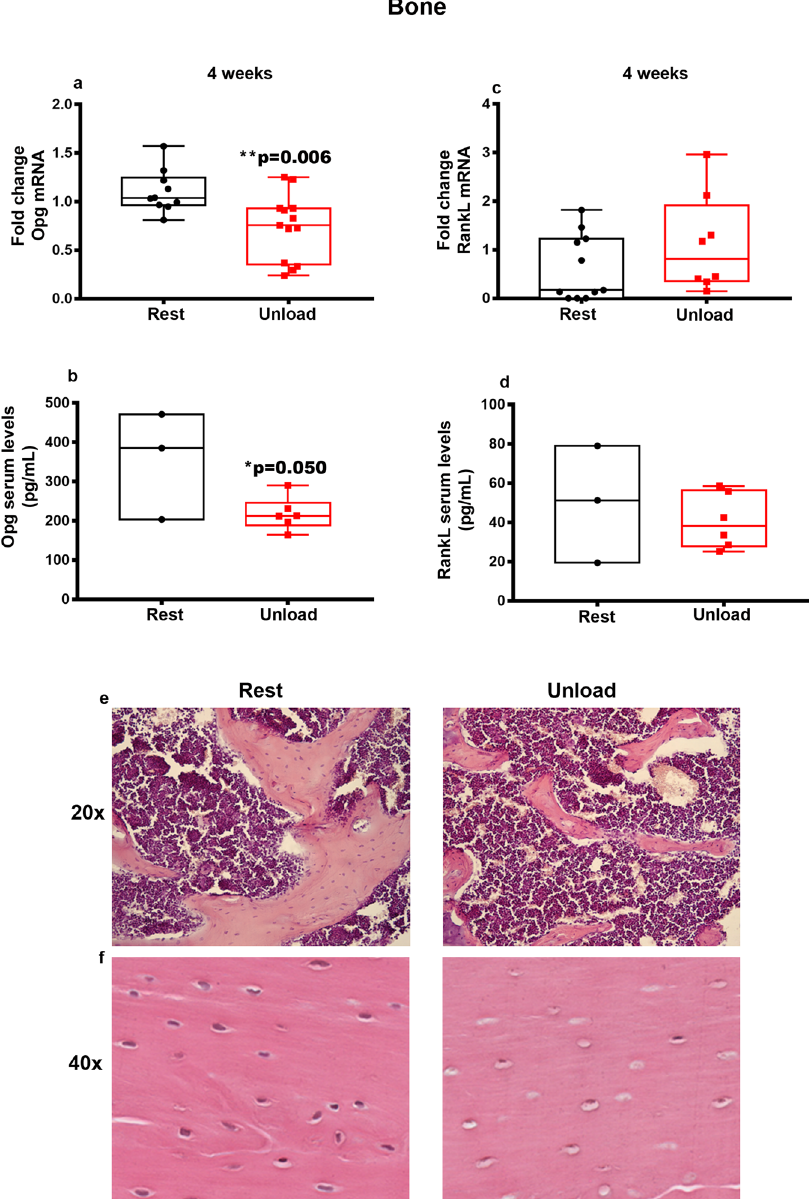
Fig. 7 Opg and RankL mRNA expression in cortical bone under unloading condition. Quantitative PCR (qPCR) showing mRNA expression levels of Opg ( a ) and RankL ( c ) in cortical bone of control mice kept in resting condition (Rest) and HU mice (Unload) at 4 weeks. Data revealed a signi fi cant reduction in Opg expression levels in unloaded mice at 4 weeks ( a ), whereas there was an increasing but not signi fi cant trend of RankL in unloaded mice at 4 weeks ( c ). Measurements of OPG and RankL serum levels after 4 weeks of HU by Elisa Assays showing a signi fi cant reduction in OPG serum levels in HU mice compared to controls ( b ), but any signi fi cant change of RankL ( d ). Photomicrographs of hematoxylin and eosin (H&E)-stained sections of trabecular bone ( e ) (magni fi cation 20x) and cortical bone ( f ) (magni fi cation 40x) of femurs from Rest and Unload mice showing reduced thickness of trabeculae and increased number of apoptotic osteocytes in Unload mice compared to controls. Shapiro-Wilk test and Mann-Whitney test were performed. Data are presented as box-and-whisker with median and interquartile ranges, from max to min, with all data points shown. * p < 0.050; ** p < 0.01 vs represent a potential countermeasure for astronauts who are exposed to microgravity during their space fl ight missions.